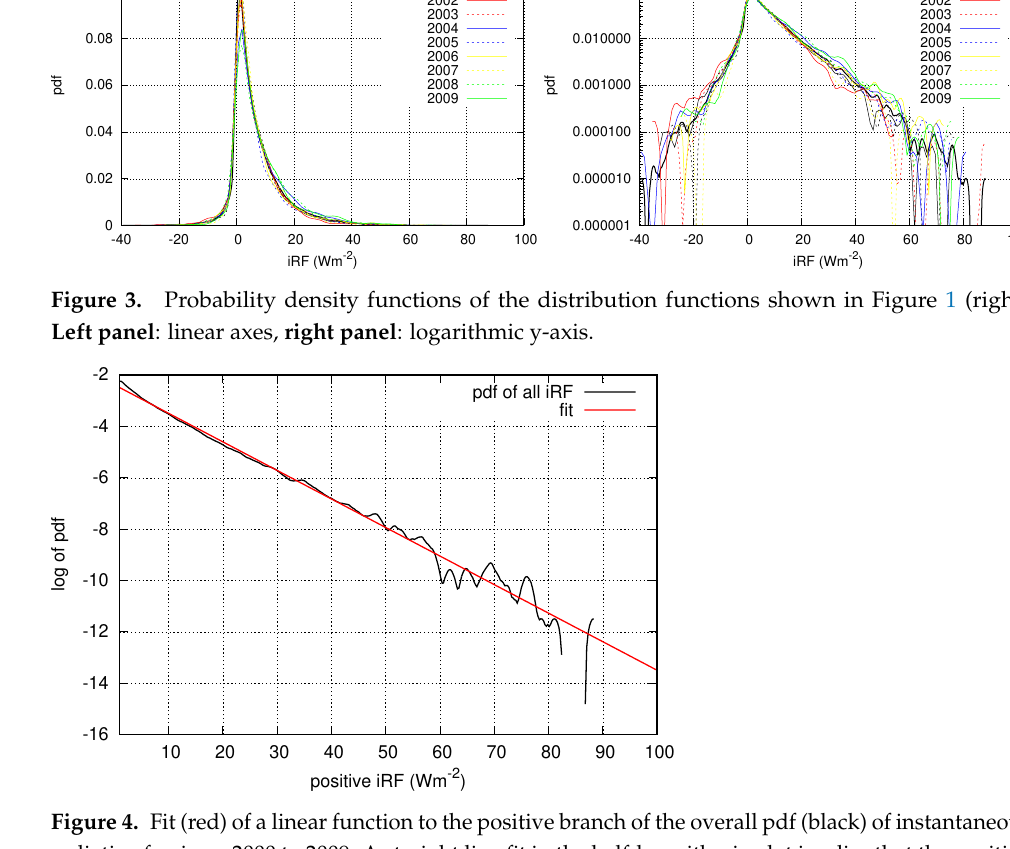
Figure 4. Fit (red) of a linear function to the positive branch of the overall pdf (black) of instantaneous radiative forcings, 2000 to 2009. A straight line fit in the half-logarithmic plot implies that the positive branch of the pdf is an exponential